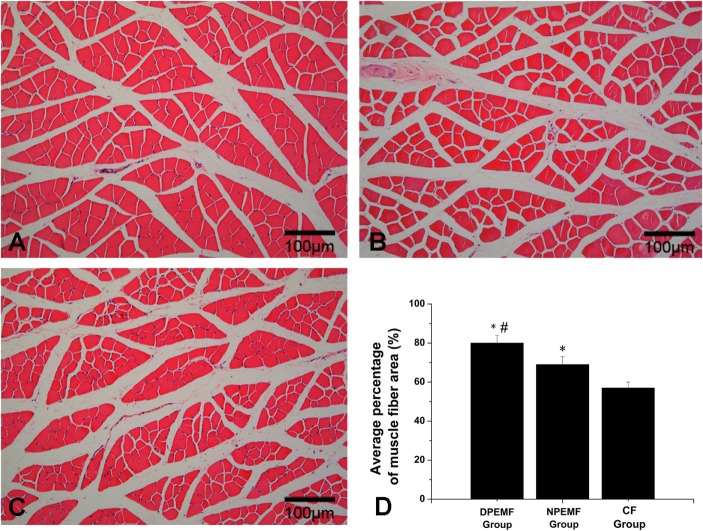
Histological analysis of target gastrocnemius muscle in each group. Representative light micrographs of the transverse-sectioned gastrocnemius muscle following HE staining for the operated limb in the DPEMF group (A), NPEMF group (B), and CF group (C) at 12 weeks postoperatively. The average percentage of muscle fiber in each group was shown in panel (D). All data were expressed as the mean ± SEM. *p < 0.05 for comparison with CF group, #p < 0.05 for comparison with CFO group.